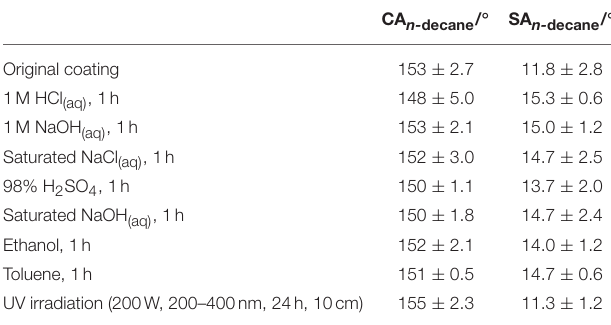
TABLE 2 | Chemical stability of the PAL/IOR@fluoroPOS